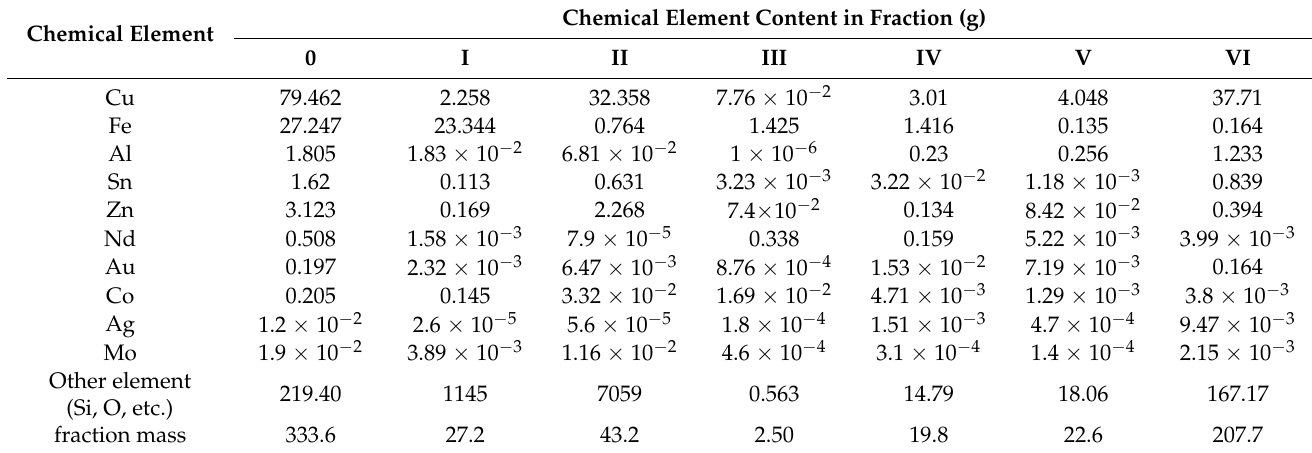
Table 9. The contents of selected chemical elements in each fraction.